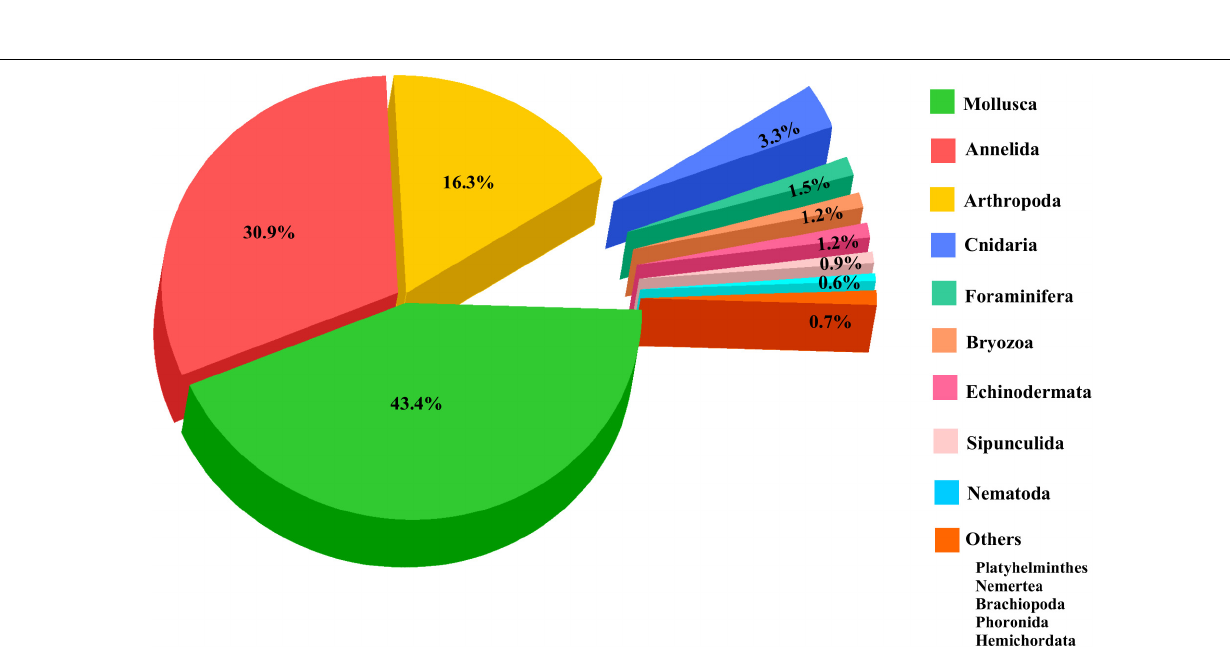
Frontiers in Marine Science |